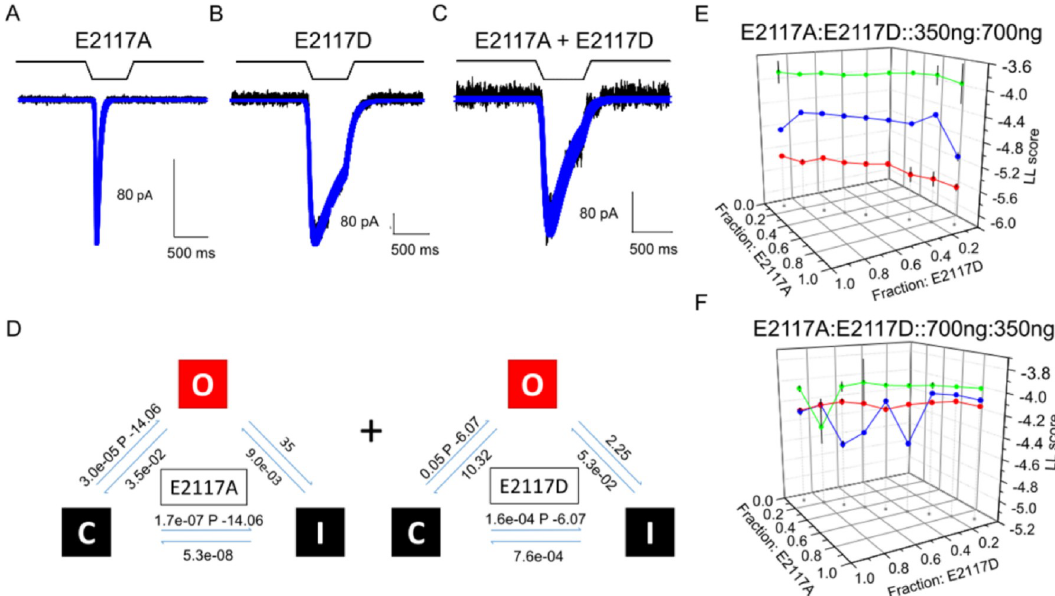
Fig 7. Modeling titration analysis of coexpressed E2117A and E2117D channels. These kinetic analyses examined whether whole- cell current from coexpressed, E2117A and E2117D, can be interpreted as arising from the sum of the currents from homomers. (A) and (B) show the current traces (in black) for the homomers. The fits (in blue) generated by models for the homomers currents are superimposed on the current traces. All kinetic models were executed in QuB. The models for macroscopic currents of homomers are in (D) with the summing operator “+”. A representative trace of the current from a cell that is coexpressing both channels is shown in (C) with the predicted current from the sum of independent homomers superimposed. (E) and (F) both show the log- likelihood (LL) values of the fits plotted against the fractions of E2117A and E2117D for a total of 300 channels. Each LL value is a measure of the congruence between the model-generated fits and the actual current trace from a patch-clamp experiment. Three data traces (red, blue and green) were used for modeling. (E) shows that the congruence between the model and experimental data is better when the fraction of E2117A channels is low and gets worse for higher fractions of E2117A. The modeling is in agreement with experimental data because transfecting with a ratio of E2117A:E2117D of 350ng:700ng (E) suggests that the cell would express fewer E2117A than E2117D. (F) , For a reversed transfection ratio (E2117A:E2117D::700ng:350ng), the congruence between the model and experimental data is better when the fraction of E2117A channels is high. Overall, these analyses show that the current in cotransfected cells, can be accounted for by the summation of the homomer currents and does not arise from a significant population of